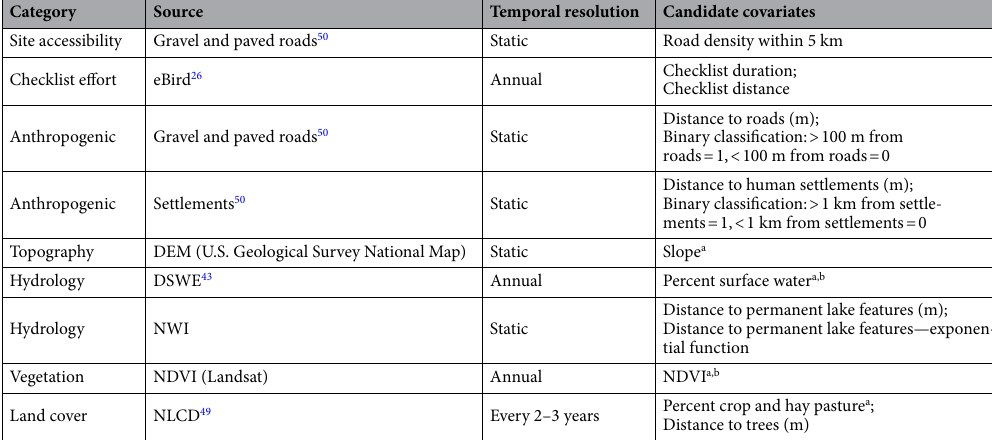
Table 1. Candidate covariates used to develop piping plover breeding density models and their data sources. Site accessibility and checklist effort covariates were only applied to the eBird observation process and remaining covariates were applied to the latent species distribution process. Temporal resolution refers to the frequency at which data layers were produced across our study period. DEM Digital elevation model; DSWE Dynamic surface water extent; NWI National wetlands inventory; NDVI Normalized difference vegetation index; NLCD National land cover database. a These covariates were considered at multiple spatial extents: 30 m, all adjacent pixels, 90 m, 150 m, 300 m, and 750 m. b These covariates included a candidate quadratic